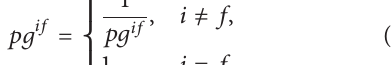
Figure 7: Success rate of proposed